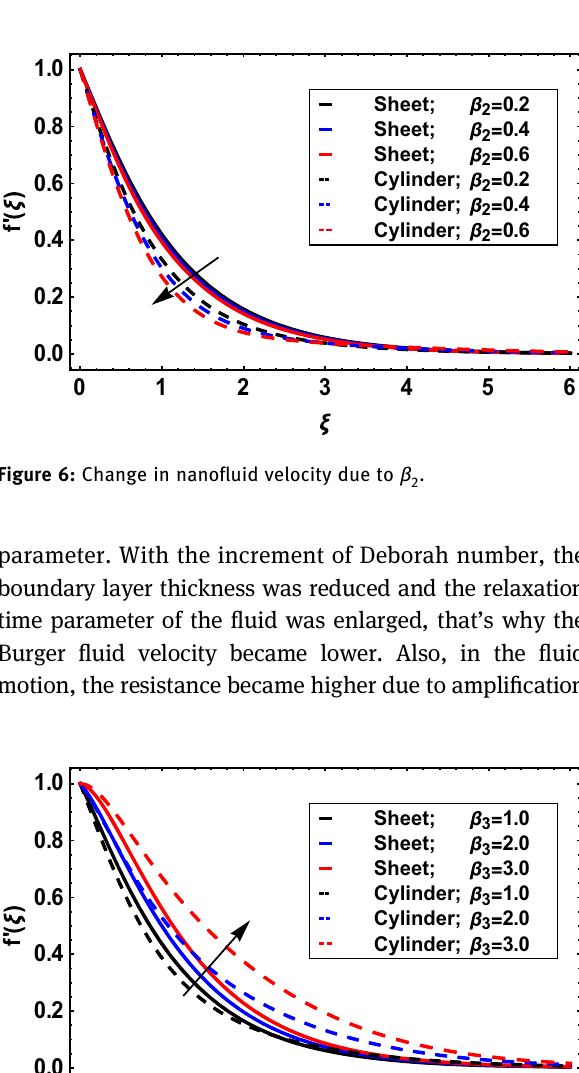
Figure 7: Change in nano fl uid velocity due to β